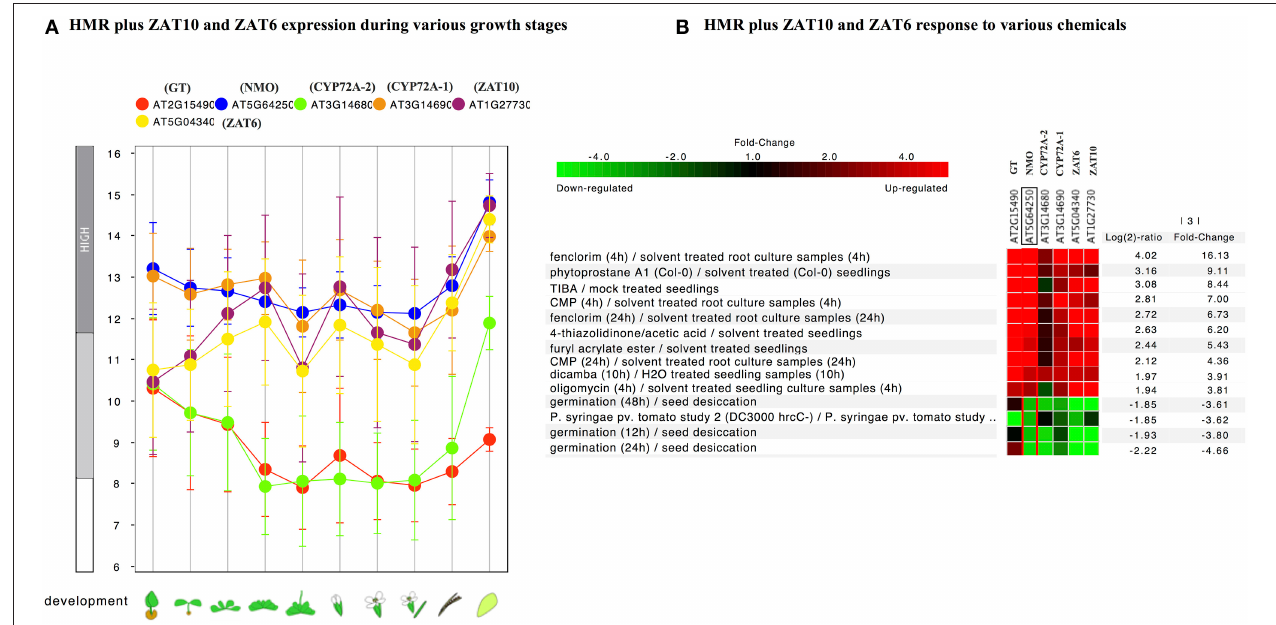
FIGURE 4 | Expression pattern of identified conserved transcription factors ZAT10 and ZAT6 genes along with of HMR. (A) Developmental stage-specific expression pattern. Left to right, “germinating seed,” “seedling,” “young rosette,” “developed rosette,” “bolting rosette,” “young flower,” “developed flower,” “flower and silique,” “mature silique,” and “senescence.” Our identified TFs were tending to show higher expression in senescence similar to genes. “HIGH,” “MEDIUM,” and “LOW” expression were based on microarray gene expression data found in GENEVESTIGATOR (http://www.genevestigator.com). (B) Heat map of the expression of identified TFs along with HMR genes under various chemical stress were analyzed using Genevestigator perturbation tool. Relative expression of the genes was represented in log 2 ratio and significant change in expression were filtered out based on NMO, p < 0.001 and fold change > 3. Expression of these genes strongly induced in response to various chemicals including herbicides and herbicide